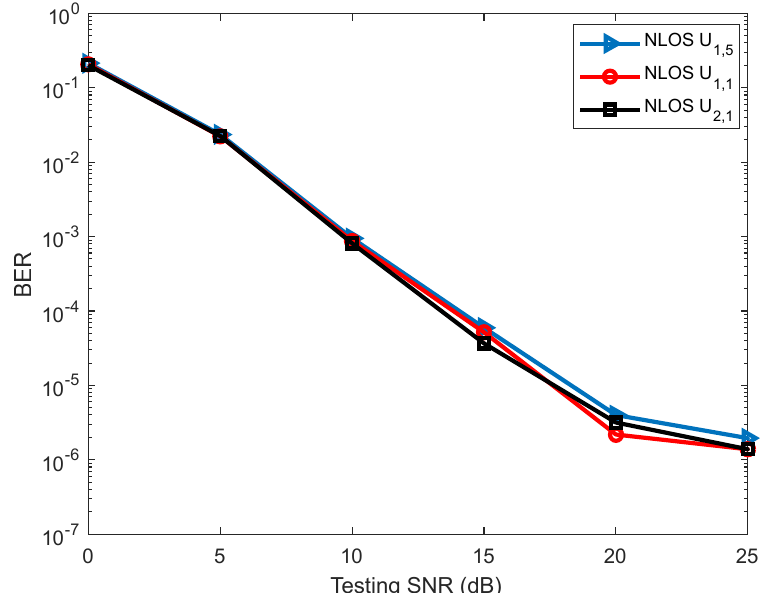
Figure 8. BER performance comparison of the proposed scheme under different NLOS cases.